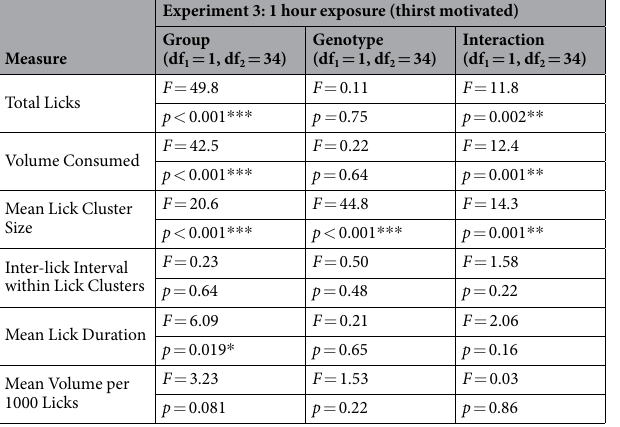
Table 3. Results of univariate ANOVAs of group (water or 32% sucrose) by genotype (WT or Gria1 − / − ), showing main effects of group and genotype, and the group x genotype interaction, for six measures of consumption behaviour in Experiment 3. Relevant degrees of freedom are given in the table headings (df 1 = between-groups degrees of freedom; df 2 = error degrees of freedom). Asterisks denote significance at various levels: * p < 0.05; ** p < 0.01; *** p < 0.001.